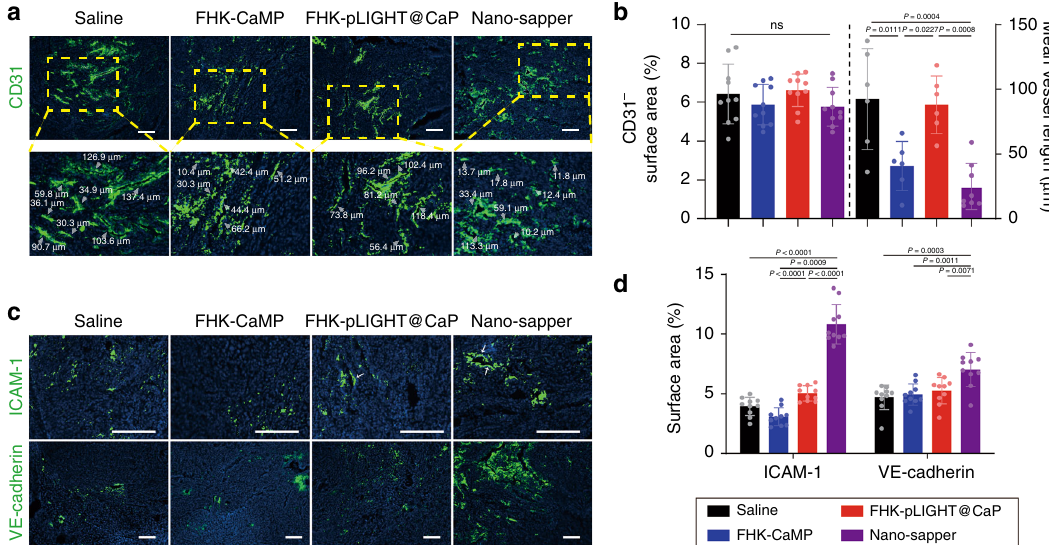
Fig. 4 Nano-sapper normalized tumor blood vessels and increased cell adhesion molecules in PDAC. a , b Tumor slices were stained with anti-CD31 and analyzed by ImageJ. Scale bars, 100 μ m. n = 10 section images from three mice. Data were pooled from three independent experiments. Grey arrows pointed the represented vessels. c , d Tumor slices were stained with anti-VE-cadherin and anti-ICAM-1 for analysis. Scale bars, 100 μ m. n = 10 section images from three mice. Data were pooled from three independent experiments. Cell nuclei was stained by DAPI. Data are presented as mean ± s.d. One- way ANOVA with Bonferroni multiple comparisons post-test was used for ( b ) and ( d ). ns, not signi fi cant. Error bars represent